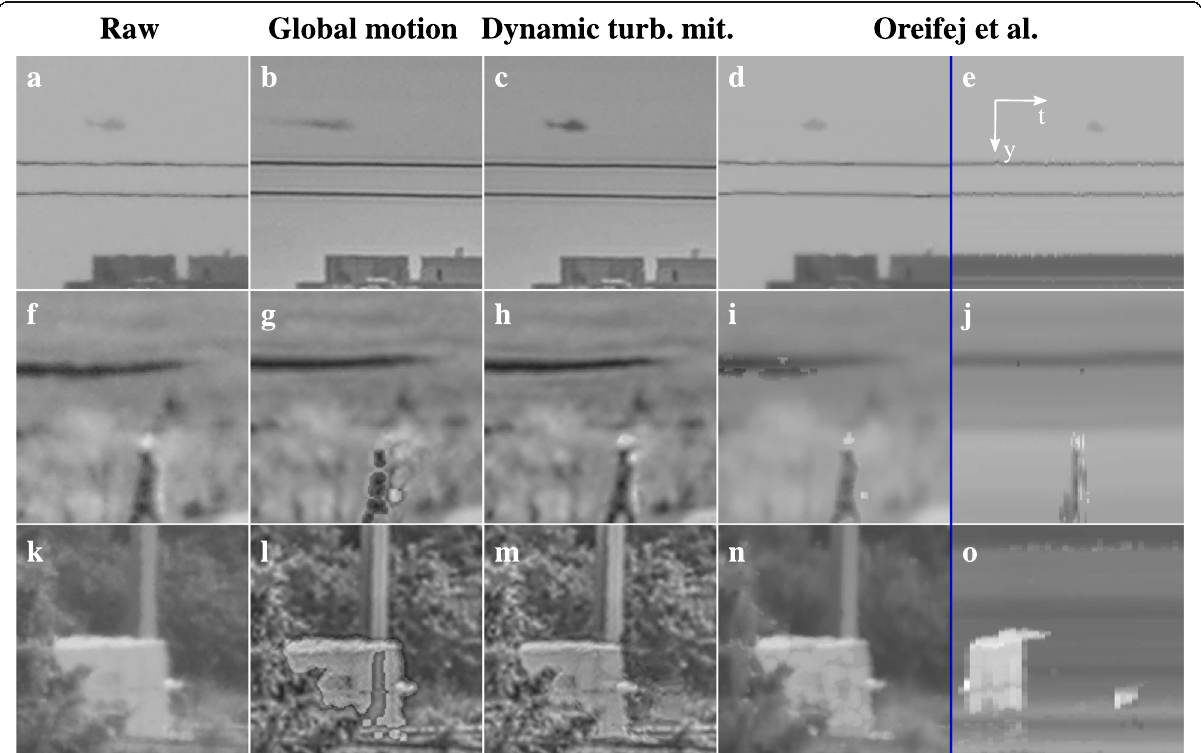
Fig. 17 Comparison of turbulence mitigation results on grayscale imagery of a golf course scene, scene with a helicopter flying over a city, and highway scene. Columns show respectively from left to right: raw frames ( a , f , k ), results obtained with our global turbulence mitigation method ( b , g , l ), results obtained with our dynamic turbulence mitigation with TV-L1 optical flow and occlusion compensation ( c , h , m ), and results obtained with the three-way decomposition approach shown as images ( d , i , n ) and temporal cross-sections ( e , j , o